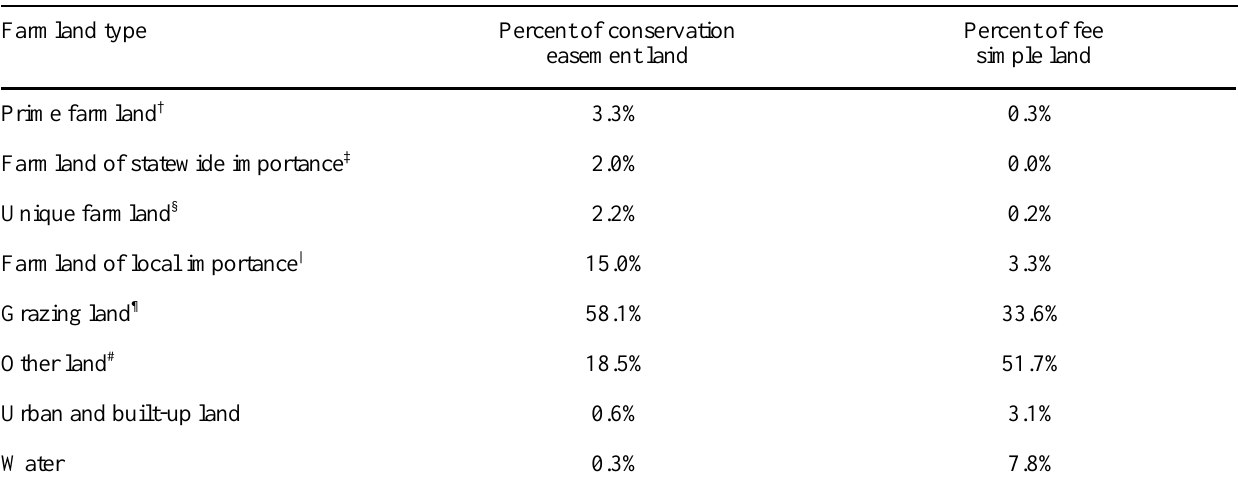
Table 5 . Farmland suitability type for conservation easements and fee-simple protected areas in the San Francisco Bay